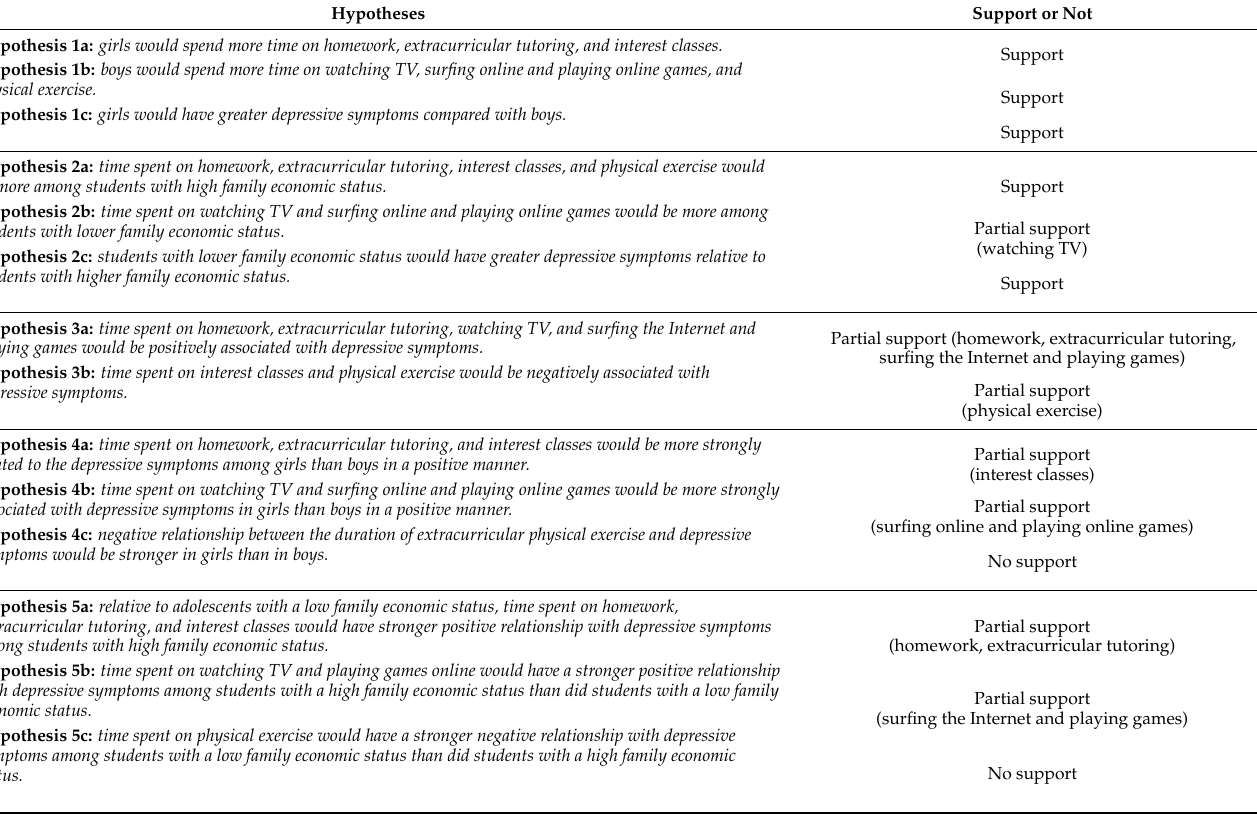
Table 7. Summarizing the support for the different